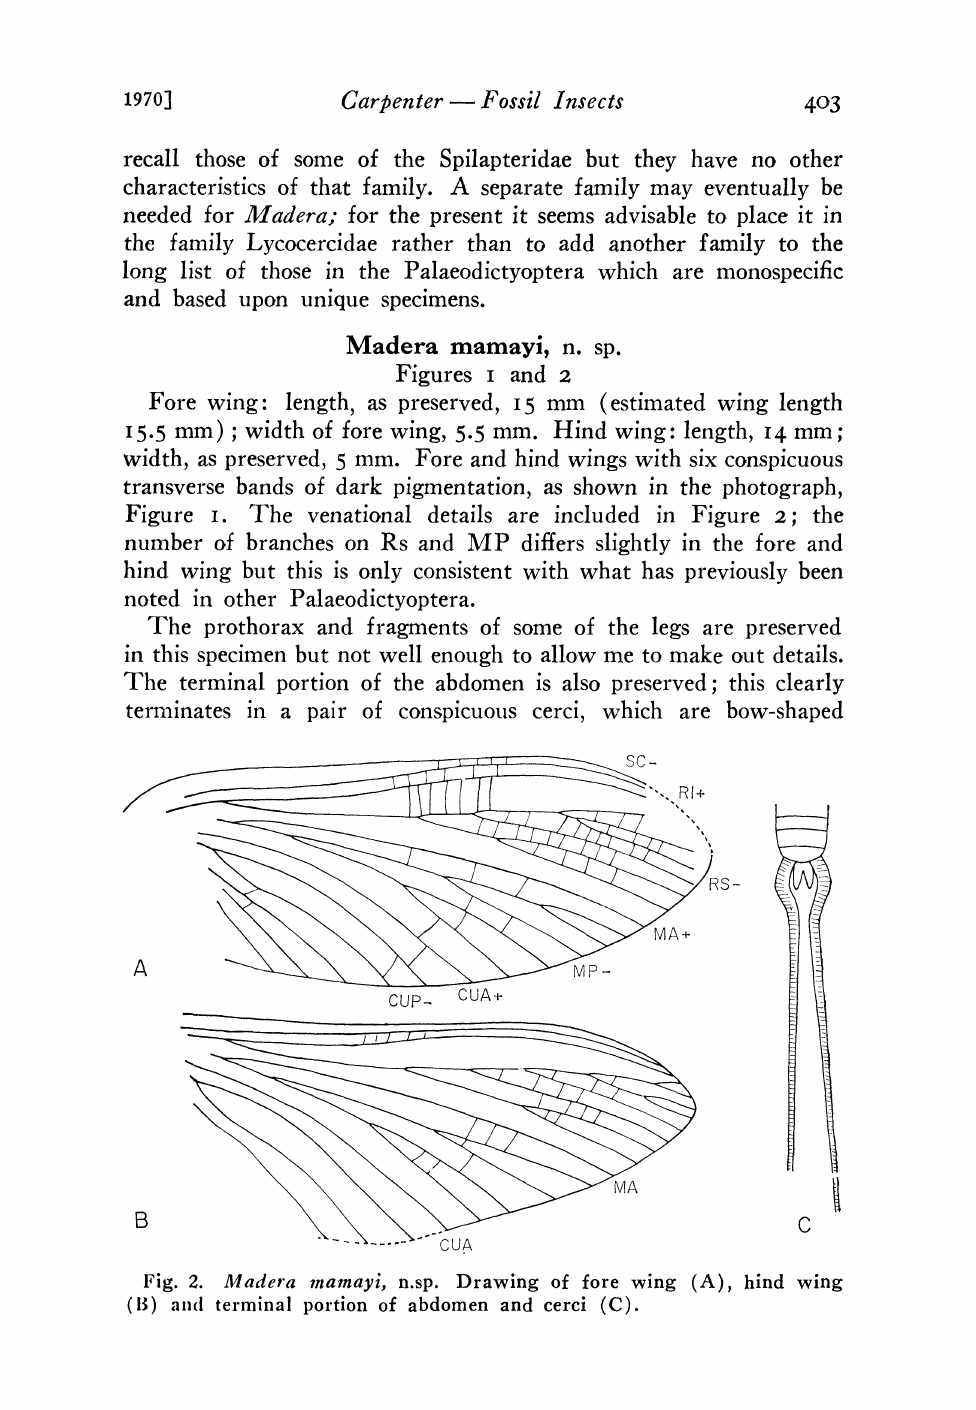
Fig. 2. Madera mamayi, n.sp. Drawing of fore wing (A), hind wing (B) and terminal portion of abdomen and cerci